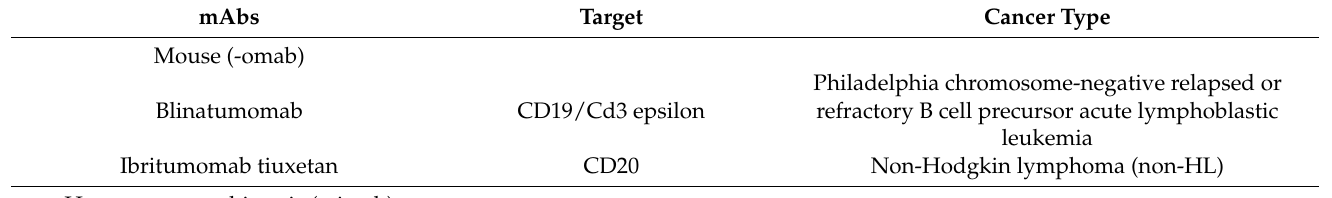
Table 1. Therapeutic monoclonal antibodies for cancer therapy currently marketed with regulatory approval from the European Medicines Agency (as of April 2020)